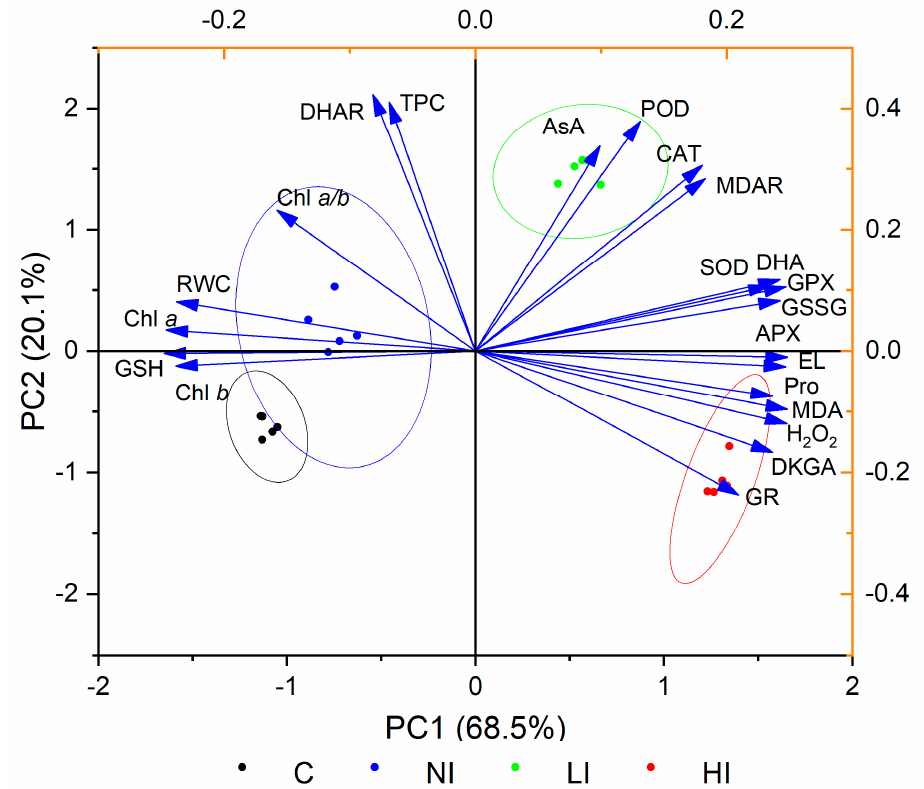
Figure 1. Principal component analysis (PCA) biplot of studied parameters grouped by variants of experiment. C, control, non-infested trees; NI, leaves from non-infested branches of infested trees; LI, leaves from branches with 1–2 mistletoe bushes (low degree of infestation); HI, leaves from branches with 5–7 mistletoe bushes (high degree of infestation). RWC, relative water content; Chl a , chlorophyll a ; Chl b , chlorophyll b ; Chl a / b , chlorophyll a / b ratio; EL, electrolyte leakage; MDA, malondialdehyde; Pro, proline; GSH, glutathione; GSSG, oxidized glutathione; AsA, ascorbic acid; DHA, dehydroascorbic acid; DKGA, 2,3-diketogulonic acid; TPC, total phenolic compounds; SOD, superoxide dismutase; CAT, catalase; APX, ascorbate peroxidase; MDAR, monodehydroascor- bate reductase; DHAR, dehydroascorbate reductase; GPX, glutathione peroxidase; GR, glutathione reductase; POD,